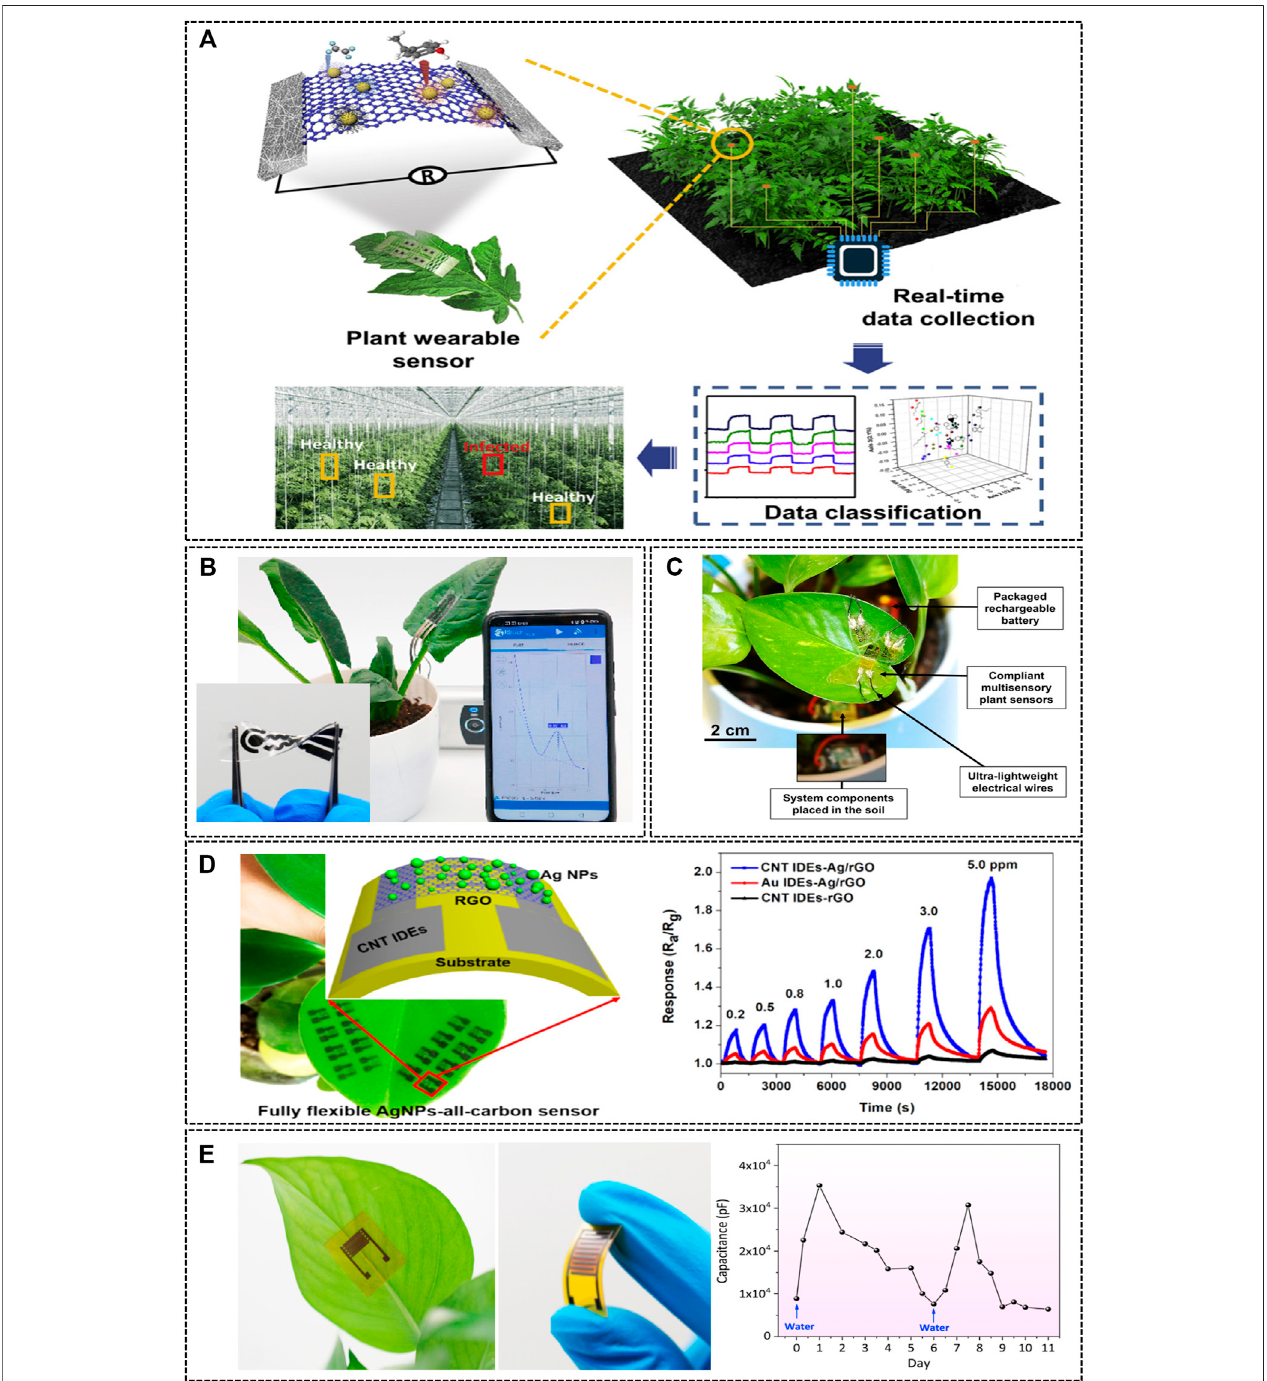
FIGURE 7 | Plant-wearable sensors for determining plant physiological signals. (A) Late blight diagnosis in tomato through an abiotic stress monitoring system for sensing volatile organic compounds using a leaf-attached chemical sensor (Z. Li et al., 2021). Copyright © 2021 (Elsevier). (B) In-situ organophosphorus pesticide analysisonthesurfacesofagriculturalproducts(inset: thefabricatedPDMS/LIG electrode)(F.Zhaoet al.,2020).Copyright © 2020(Elsevier). (C) Anenvironmentalplant sensor platform on the surface of a plant leaf (Nassar et al., 2018). Copyright © 2018 (Nature). (D) A gas sensor array attached to a real plant leaf, and schematic illustration of the fl exible sensing device (left) and real-time response curves (right) (W. Li et al., 2018). Copyright © 2018 (American Chemical Society). (E) Plant humidity sensor for real-time monitoring; a humidity sensor attached to the back surface of a leaf (left) and the graphene oxide-based sensor (middle), and the capacitance response to drought stress (right) (Lan et al., 2020). Copyright © 2020 (Elsevier).